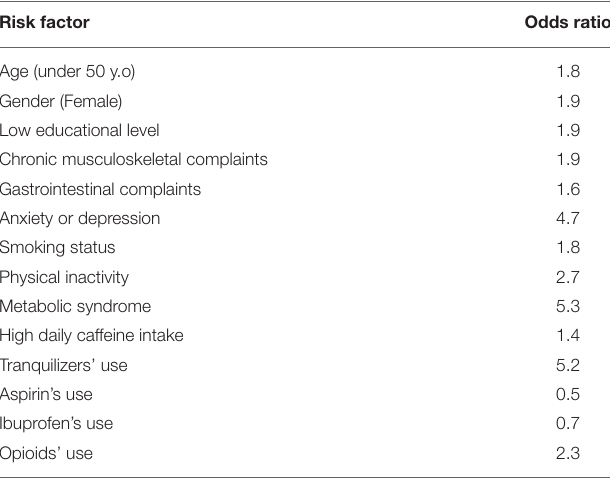
TABLE 1 | Risk factors for MOH and associated odds ratios identified in three studies [Hagen et al. (4), Scher et al. (5), and He et al. (6)]. Risk factor Odds ratio Age (under 50